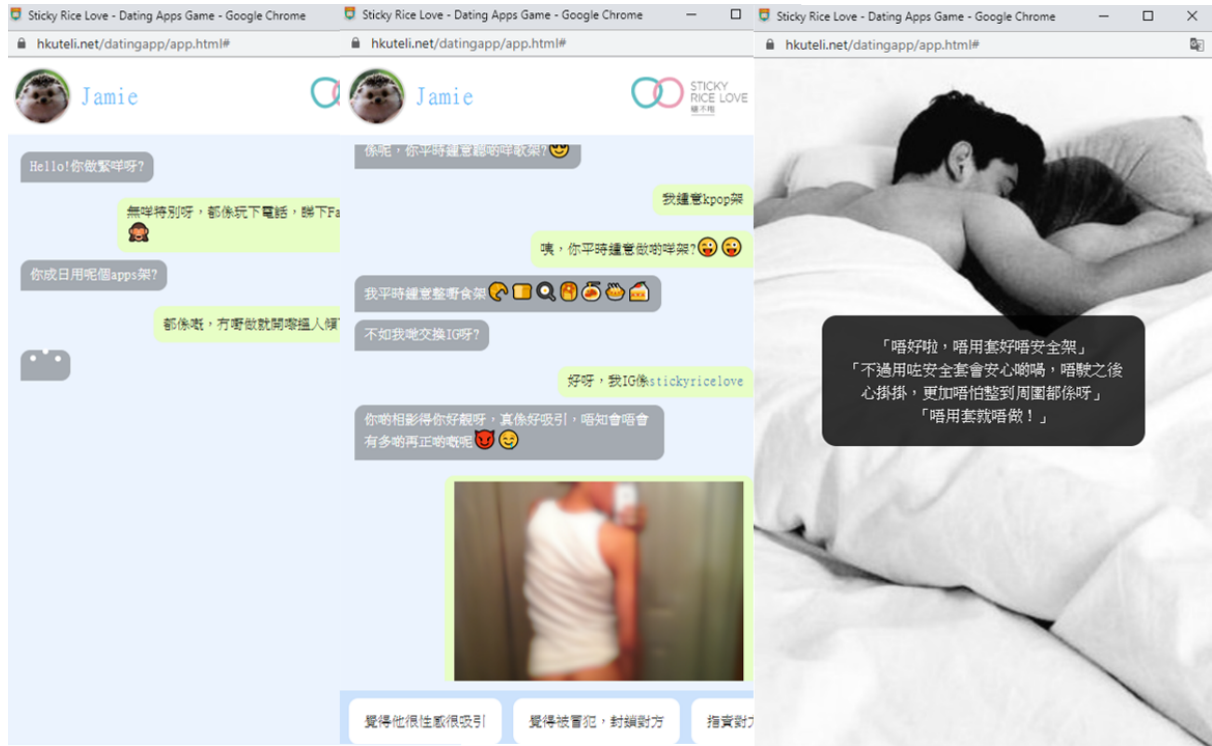
Figure 1. Screenshots of the online